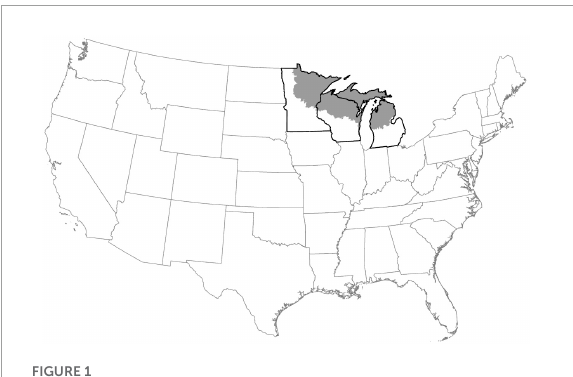
FIGURE1 Laurentian Mixed Forest Province (shaded) of the Great Lakes states of Michigan, Minnesota, and Wisconsin (Source: Cleland et al.,